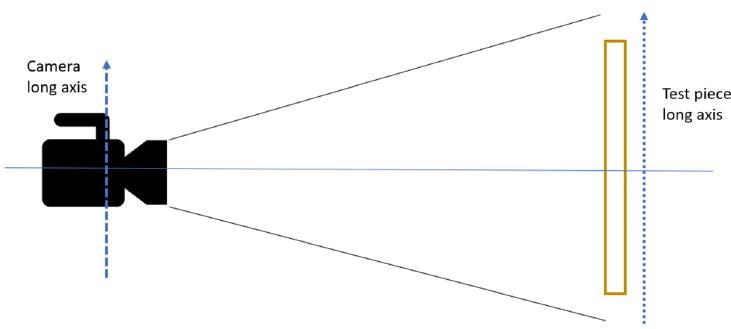
Figure 3. Digital Image Correlation setup used in measurement of the tensile properties.